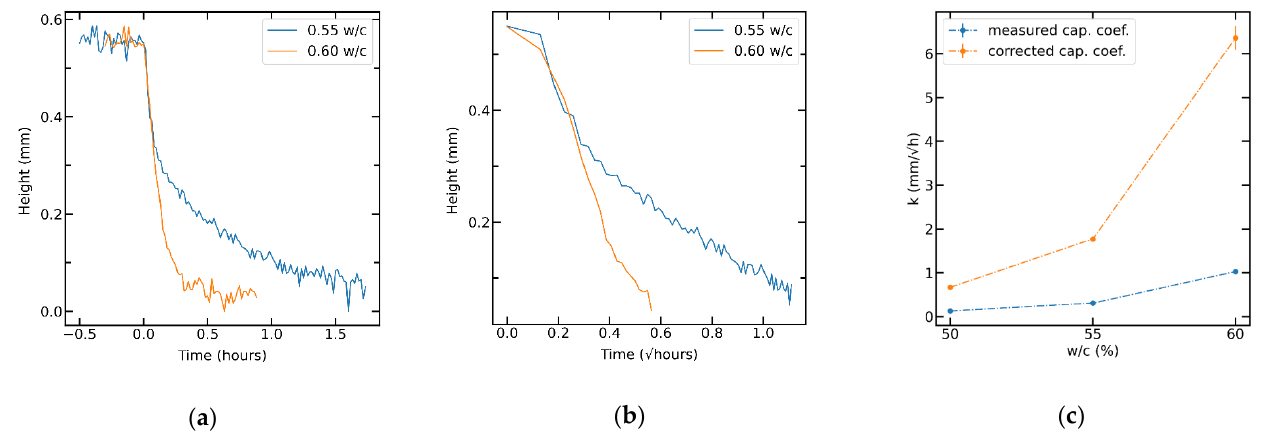
Figure 9. ( a ) Reflected light intensity for cement paste samples C (0.55 w/c ) and F (0.60 w/c ) converted to height of water at the fiber tip through Equation (5). ( b ) Slopes of the height as a function of the square root of time and ( c ) measured capillary coefficient for samples B (0.50 w/c ), C and F, and their corrected values using the slopes of Figure 4d.